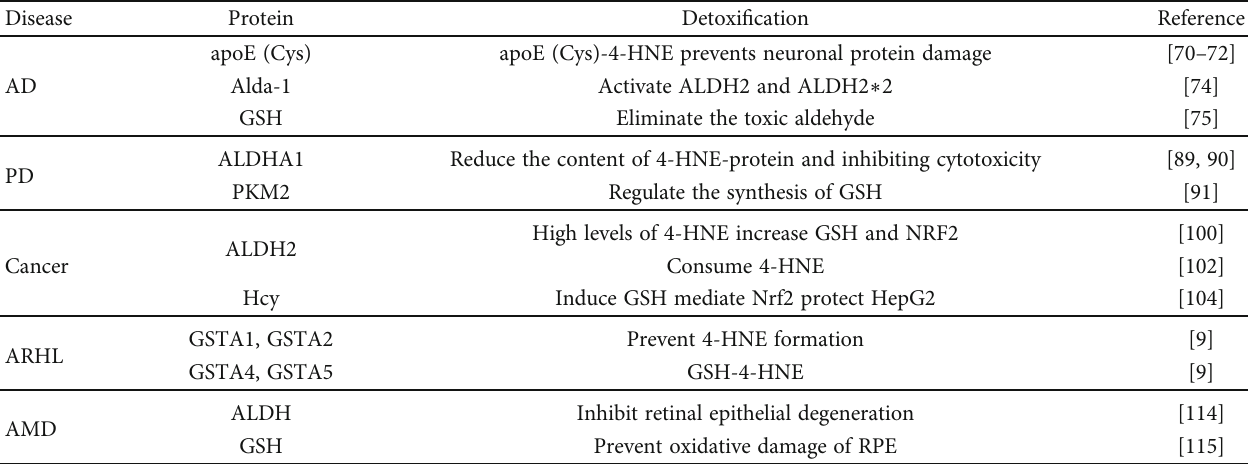
Table 1: Pharmacological measures of 4-HNE detoxi fi cation.